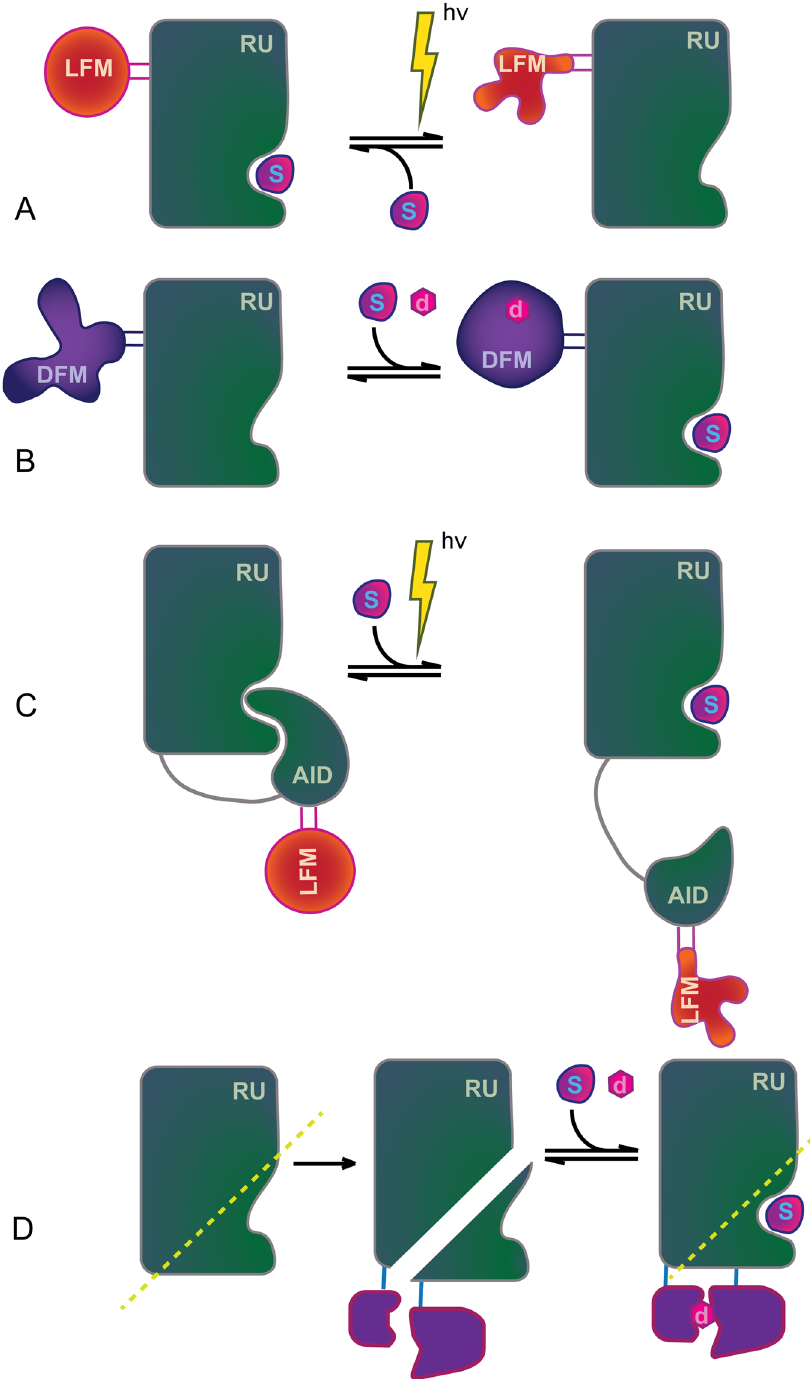
Fig. 3 Some of the established modes of protein control 26,27 . A Photo-allosteric inhibition (e.g., using LOV2): upon irradiation with light, disorder induced in LOV2 (LFM) allosterically induces increased fl uctuations in the active site, thereby inhibiting interaction with the substrate, S. B Chemo-allosteric inhibition: an engineered DFM (e.g., uniRapR) undergoes disorder-order transition upon addition of a small molecule (rapamycin); thereby, allosterically promoting interaction with the substrate. C Photo-allosteric activation: similar to A but LFM is inserted